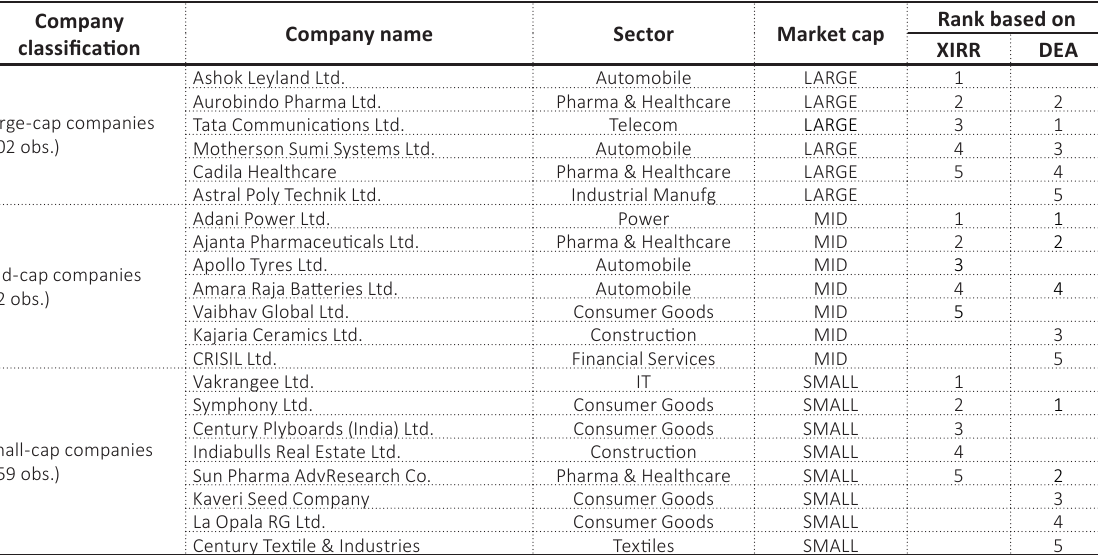
Table 6. Comparison of rankings of highest performing companies by market